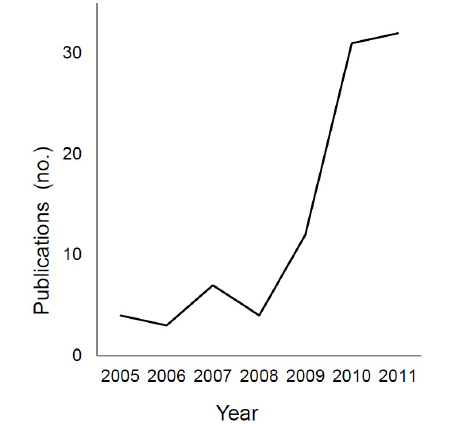
Fig. 1 . Number of publications per